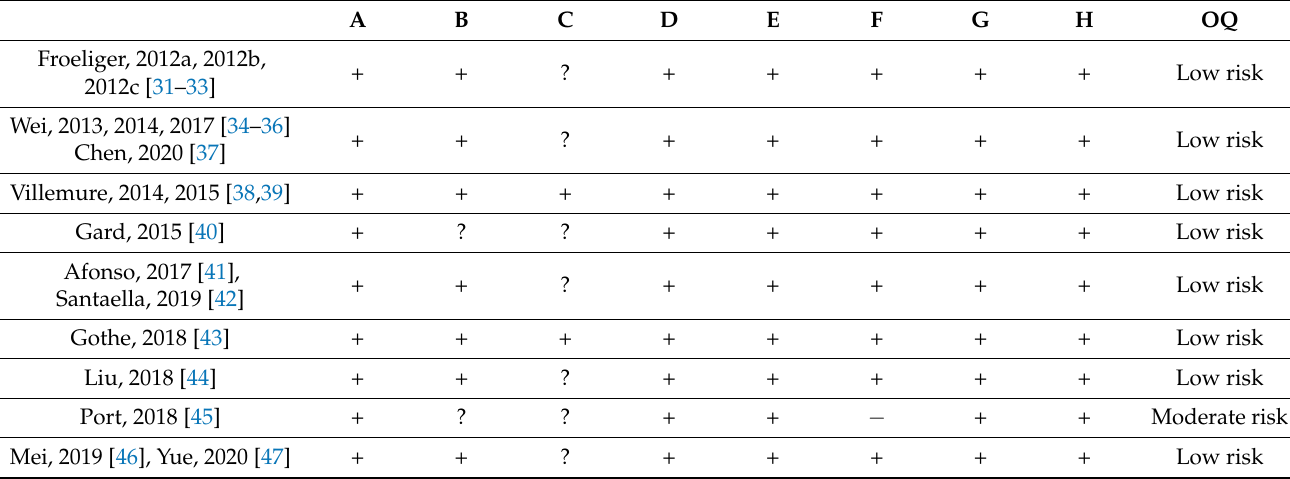
Table 3. Quality assessment of the included cross-sectional studies.